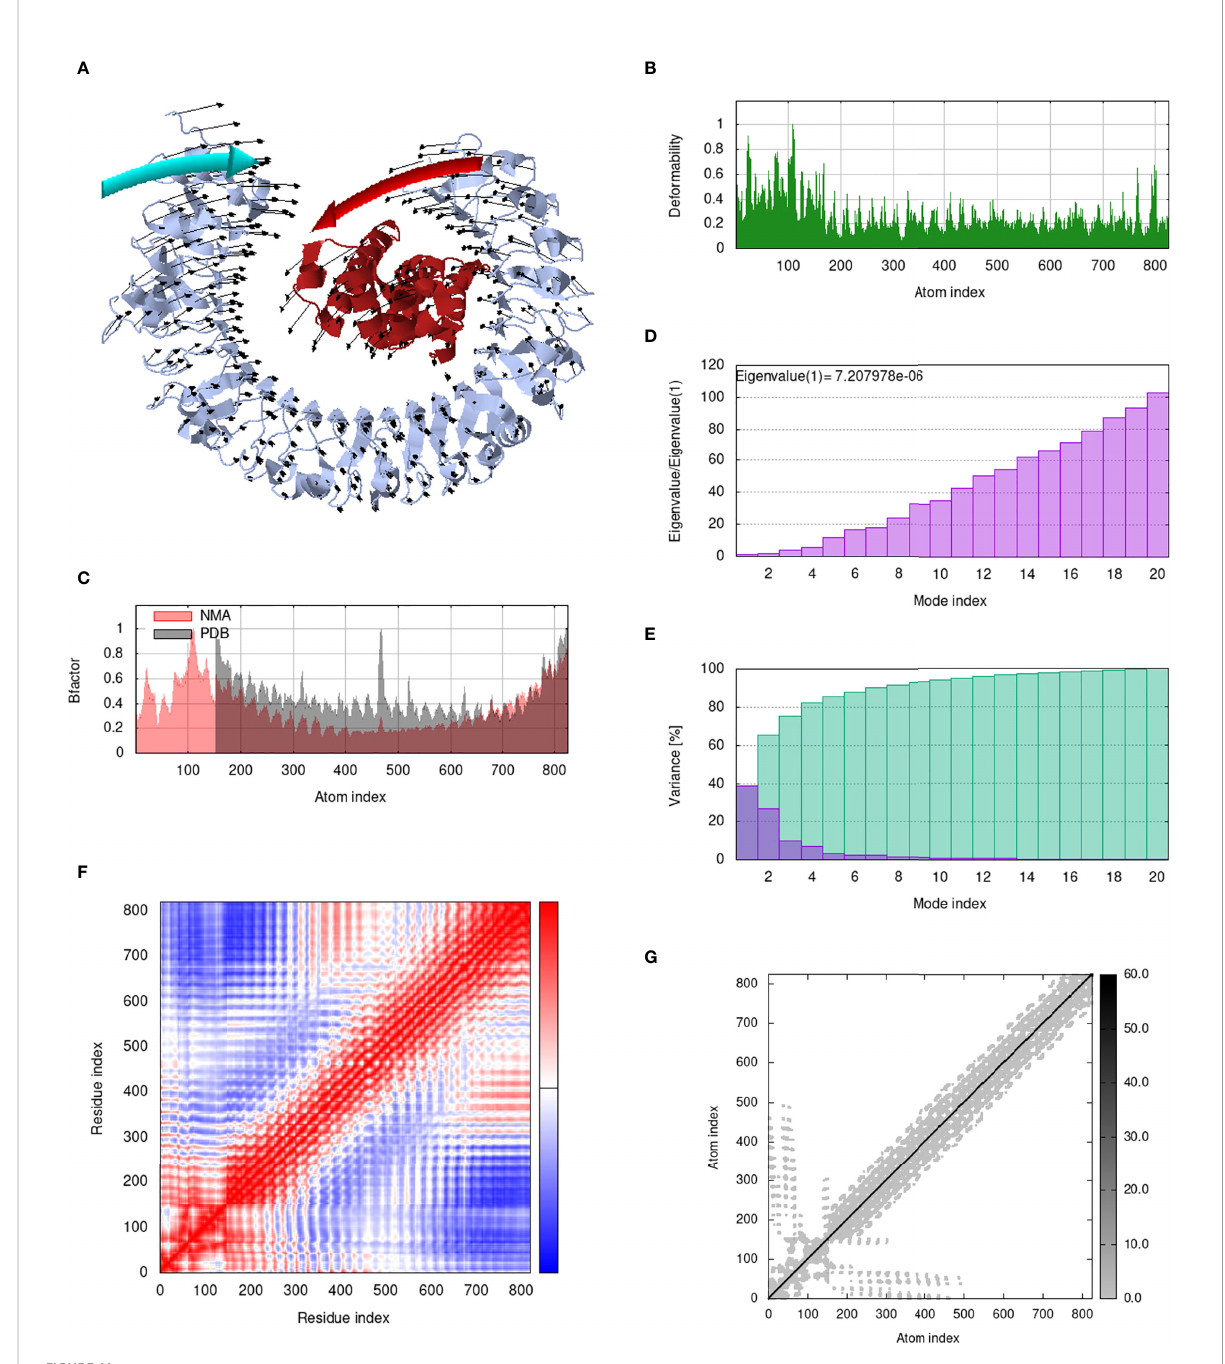
FIGURE 11 Analysis of the vaccine-TLR3 complex in normal mode. (A) Structural strength of the re fi ned protein-protein complex mobility; (B) deformability in relation to atoms; (C) B-factor in relation to atoms; (D) eigenvalue in relation to modes; (E) Structural variance; (F) covariance in relation to residue; (G) elastic network in relation to